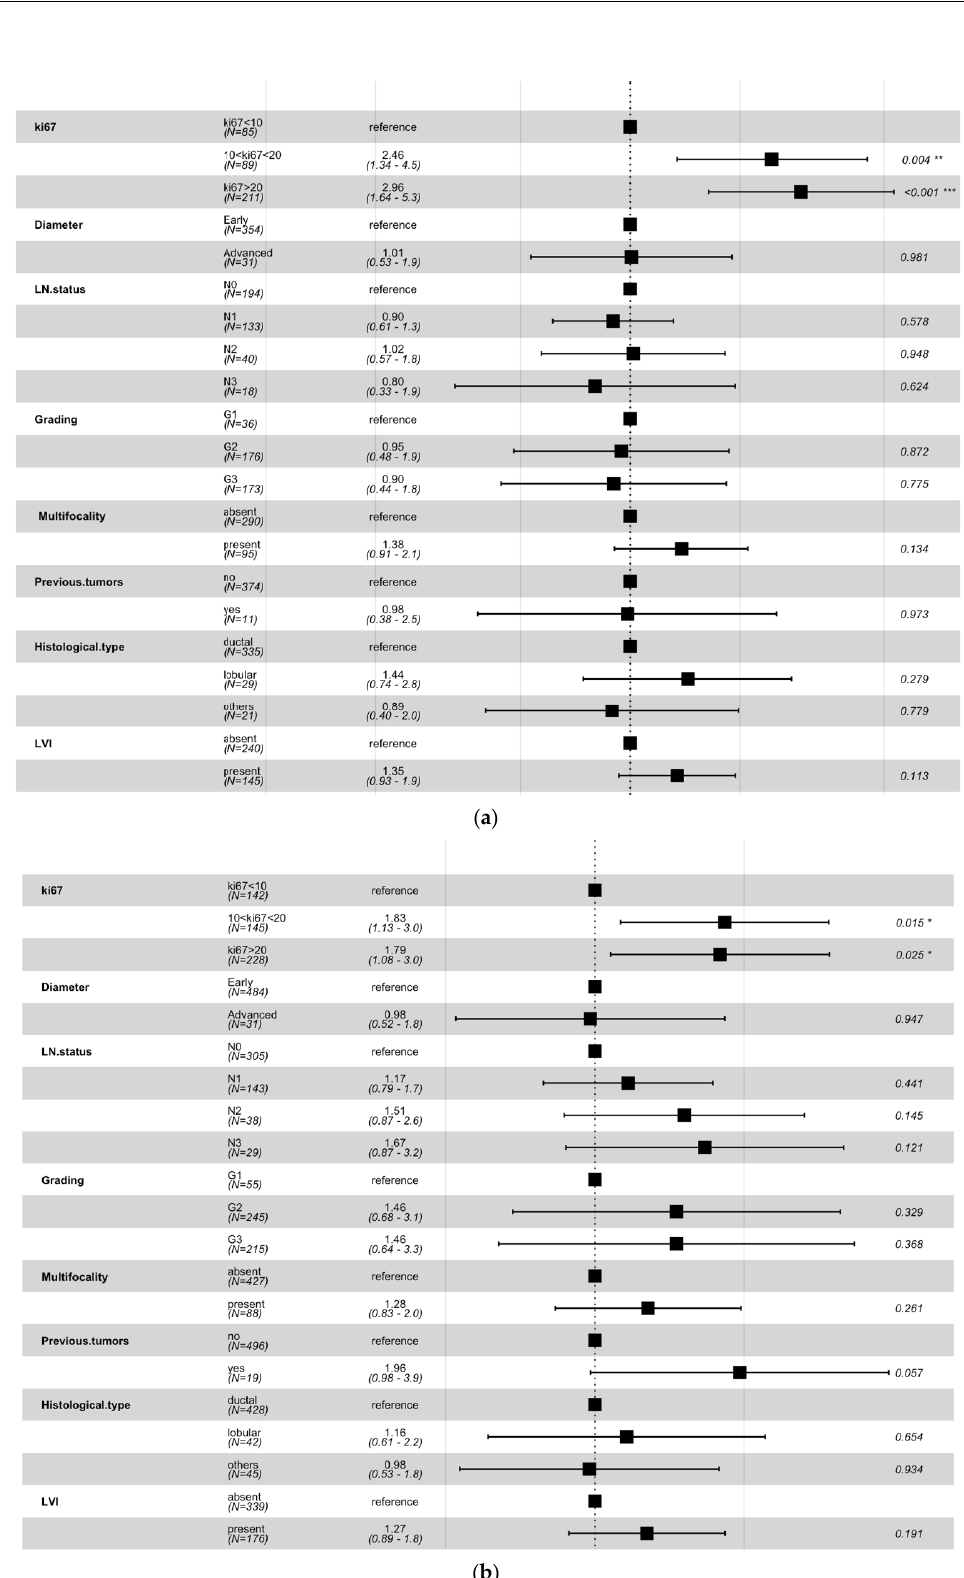
Figure 4. Multivariate analysis performed on patients under 50 years old ( a ) and over 50 years old ( b ) by means of the Cox proportional-hazard model. For each involved variable, the hazard rates (third column) and the p -values (last column) were computed by the model with respect to a specific reference value. * p -value < 0.05, ** p -value < 0.01, *** p -value <